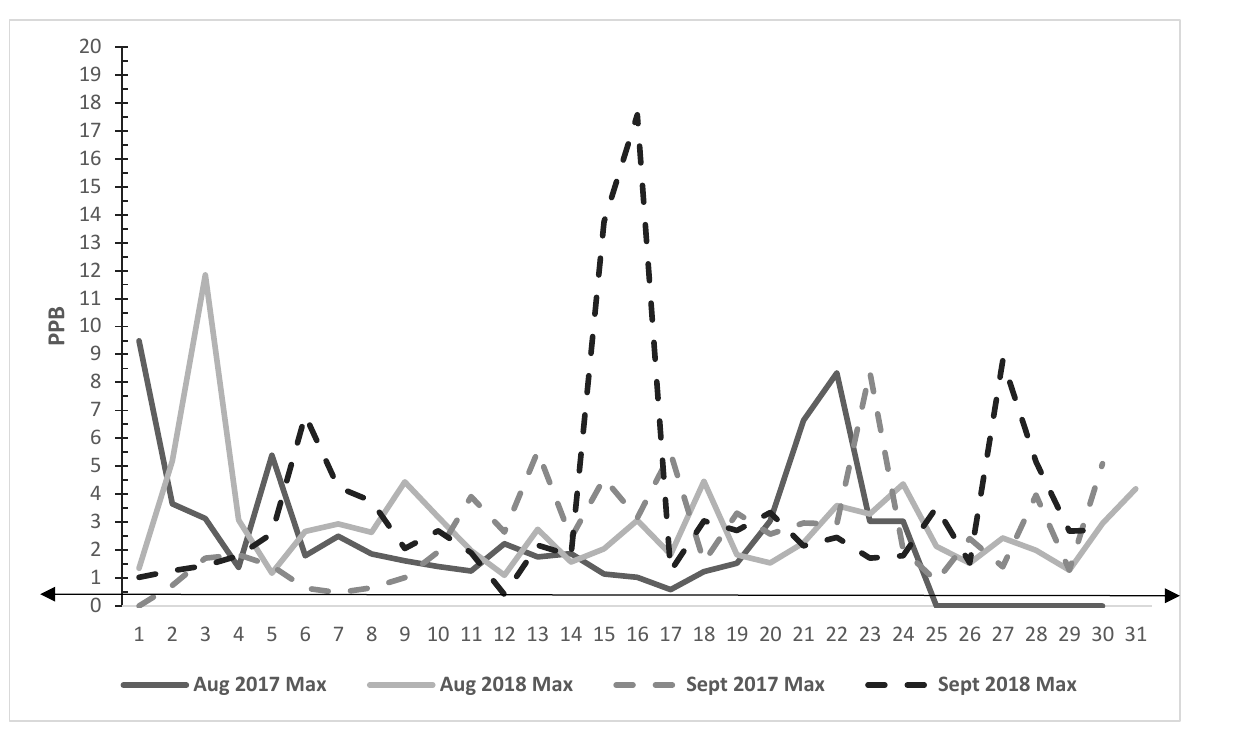
Figure 4. Beaumont Mary Air Monitor Hydrogen Sulfide MAX Values 30-Day Period, August 2017–2018 with Smell Line Arrow. Note: Figure 4 shows air monitoring data in parts per billion (PPB) for H 2 S for the month of August in 2017 and 2018. Missing data shown at end of the month of August in 2017. Smell line arrow signifies the level at which H2S can be smelled in the air.